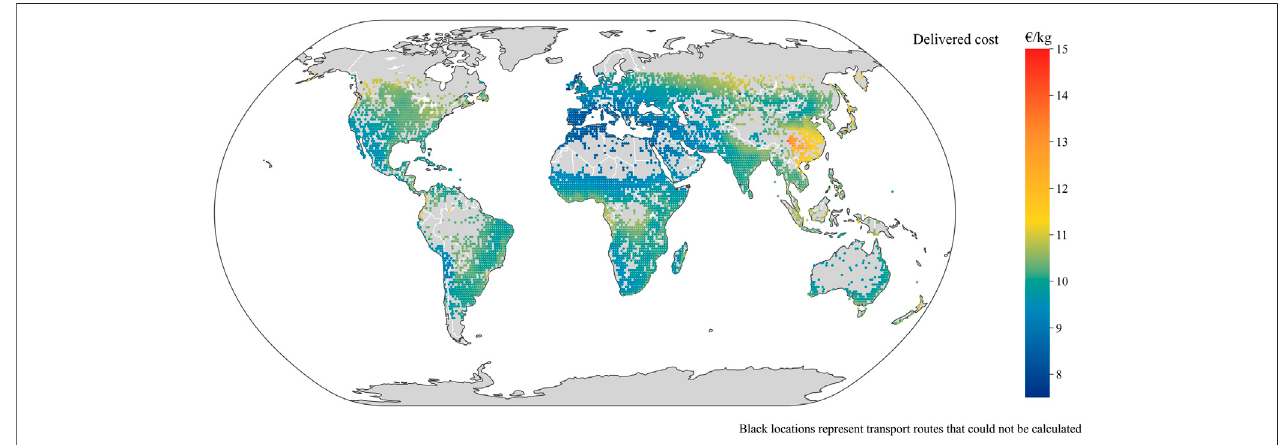
FIGURE 13 | The total (delivered) cost per kg of producing and transporting H 2 to Cologne, Germany, for large demand (1,000 kt/y) and allowing pipelines from production sites to Cologne. Other parameters follow the baseline scenario (AE electrolyser in 2030, centralised reconversion). Black dots represent locations where possible transport routes could not be found. Results are from a Monte Carlo simulation with 1,000